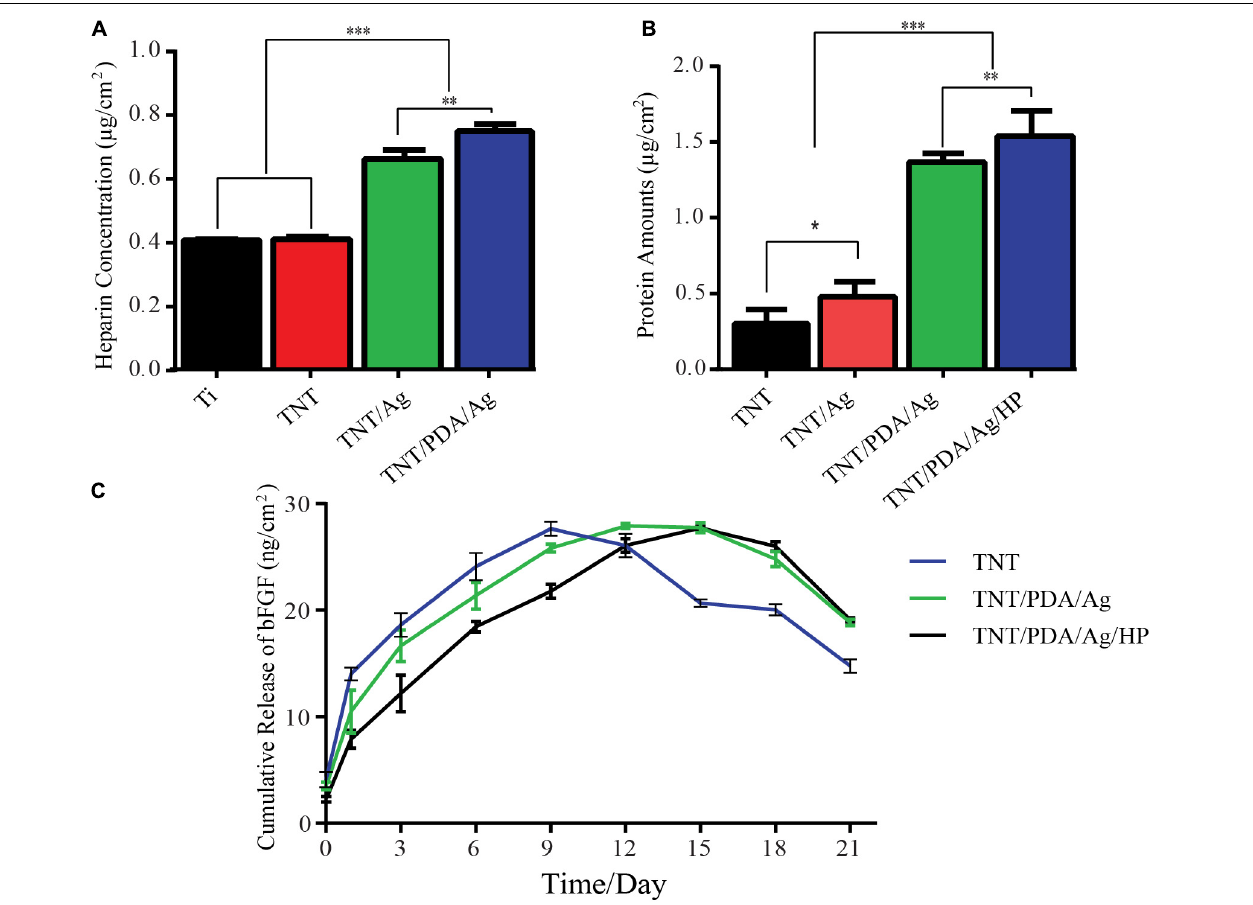
FIGURE 4 | In vitro loading and release tests of modified Ti samples. (A) Heparin loading assay: samples were immersed in 1 ml of phosphate-buffered saline (PBS) (pH 7.4) containing 0.005% toluidine blue solution for 40 min, and solutions were measured at 620 nm. TNT/PDA/Ag surface showed the highest heparin loading capacity. (B) Bovine serum albumin (BSA) release of modified Ti samples: a total of 500 µ g of BSA per modified Ti samples was added and left for 2 h. The adsorbed amount of BSA was quantified using a bicinchoninic acid kit (BCA) kit assay (570 nm). TNT/PDA/Ag/HP showed the highest protein adsorption among all modified surfaces. (C) Cumulative release of basic fibroblast growth factor (bFGF) from modified Ti samples in PBS (pH: 7.4) at 37 ◦ C measured by ELISA. Both TNT/PDA/Ag and TNT/PDA/Ag/HP displayed a slow release, with the latter being even more slowly. TNT, TNT/PDA/Ag, and TNT/PDA/Ag/HP reached the release peak on days 9, 12, and 15, respectively. Data are presented as mean ± standard deviation; ∗ p < 0.05, ∗∗ p < 0.01, and ∗∗∗ p <